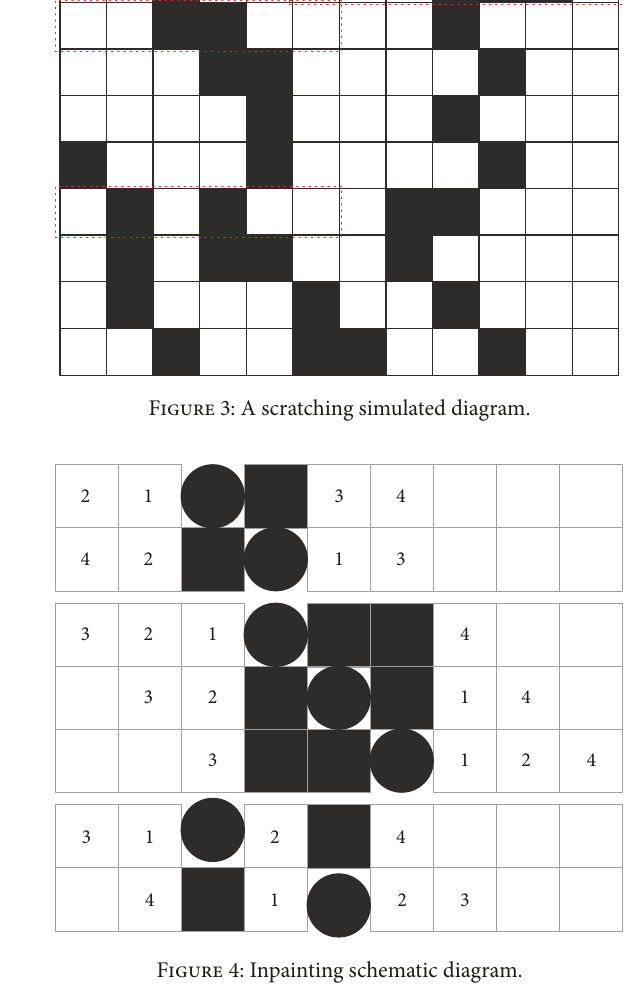
selection rule is principle of proximity and the interpolation sampling points are selected by the way of bilateral